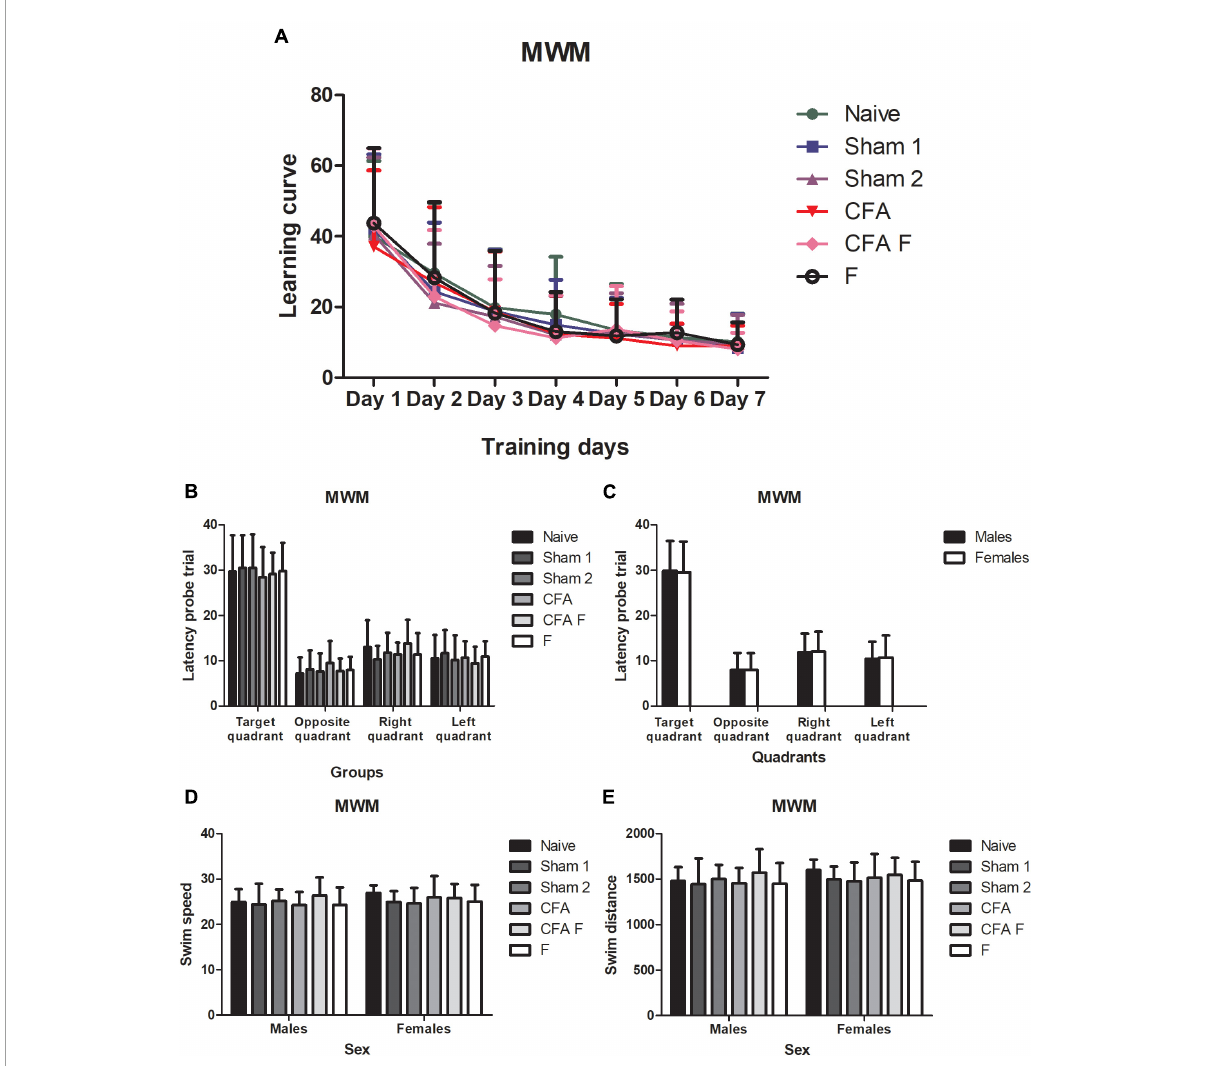
FIGURE6 (A) All animals demonstrated a clear reduction in latency equally over seven days. (B) The groups showed the same preference for target quadrant. (C) No differences were observed between sexes about preference for quadrant. (D) Males and females of all groups did not show differences for swim speed. (E) Males, and females of all groups did not show differences for swim distance. MWM, Morris water maze.